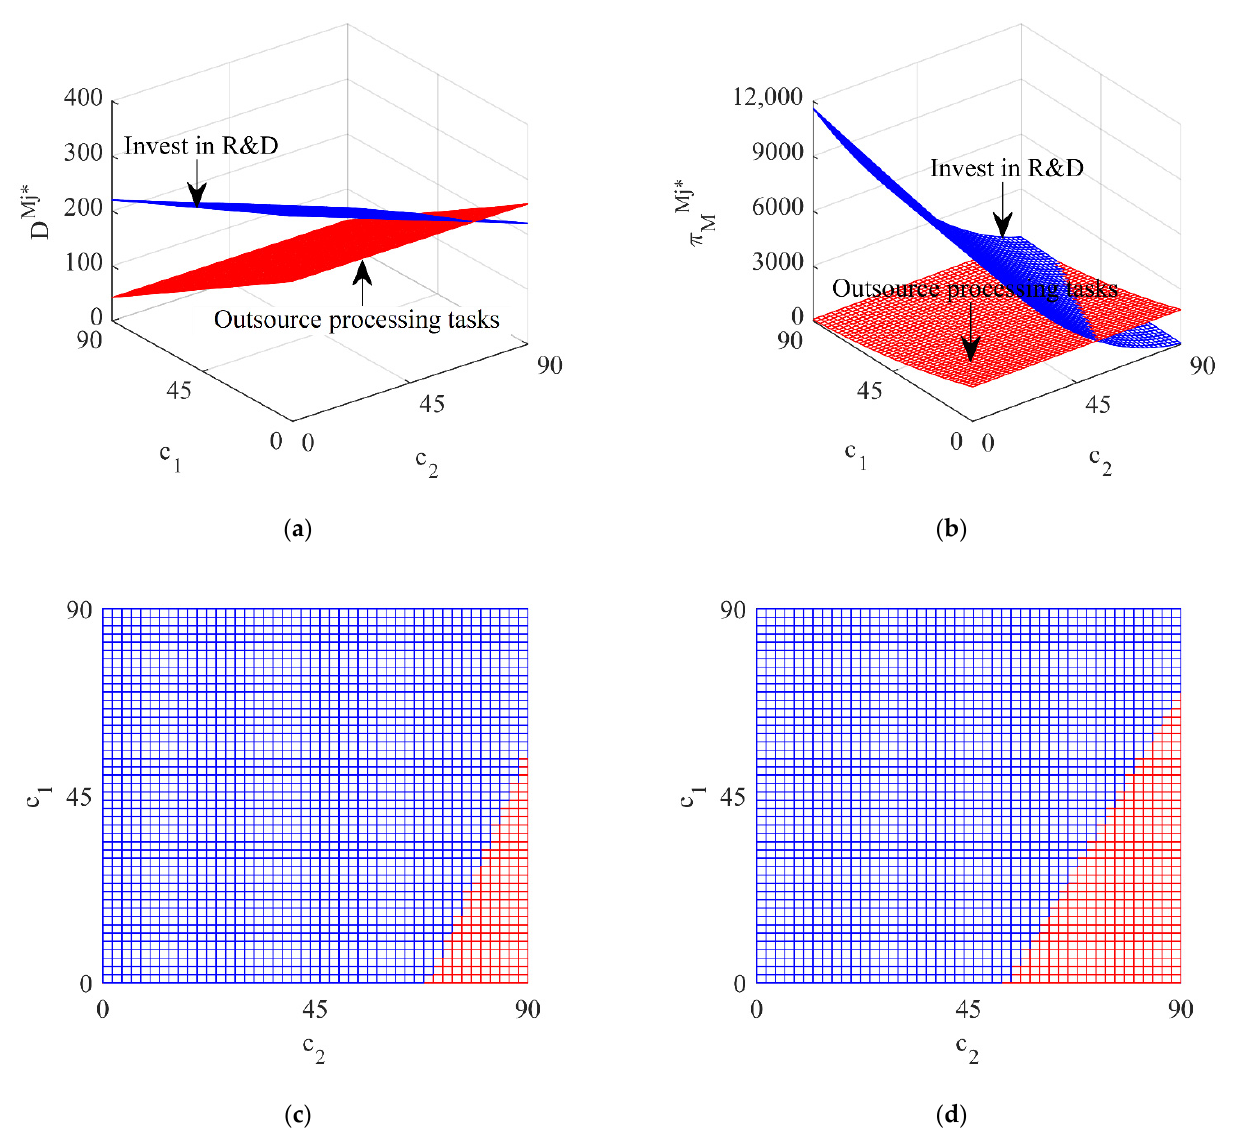
π under subsidizing the ∗ under subsidizing the M M